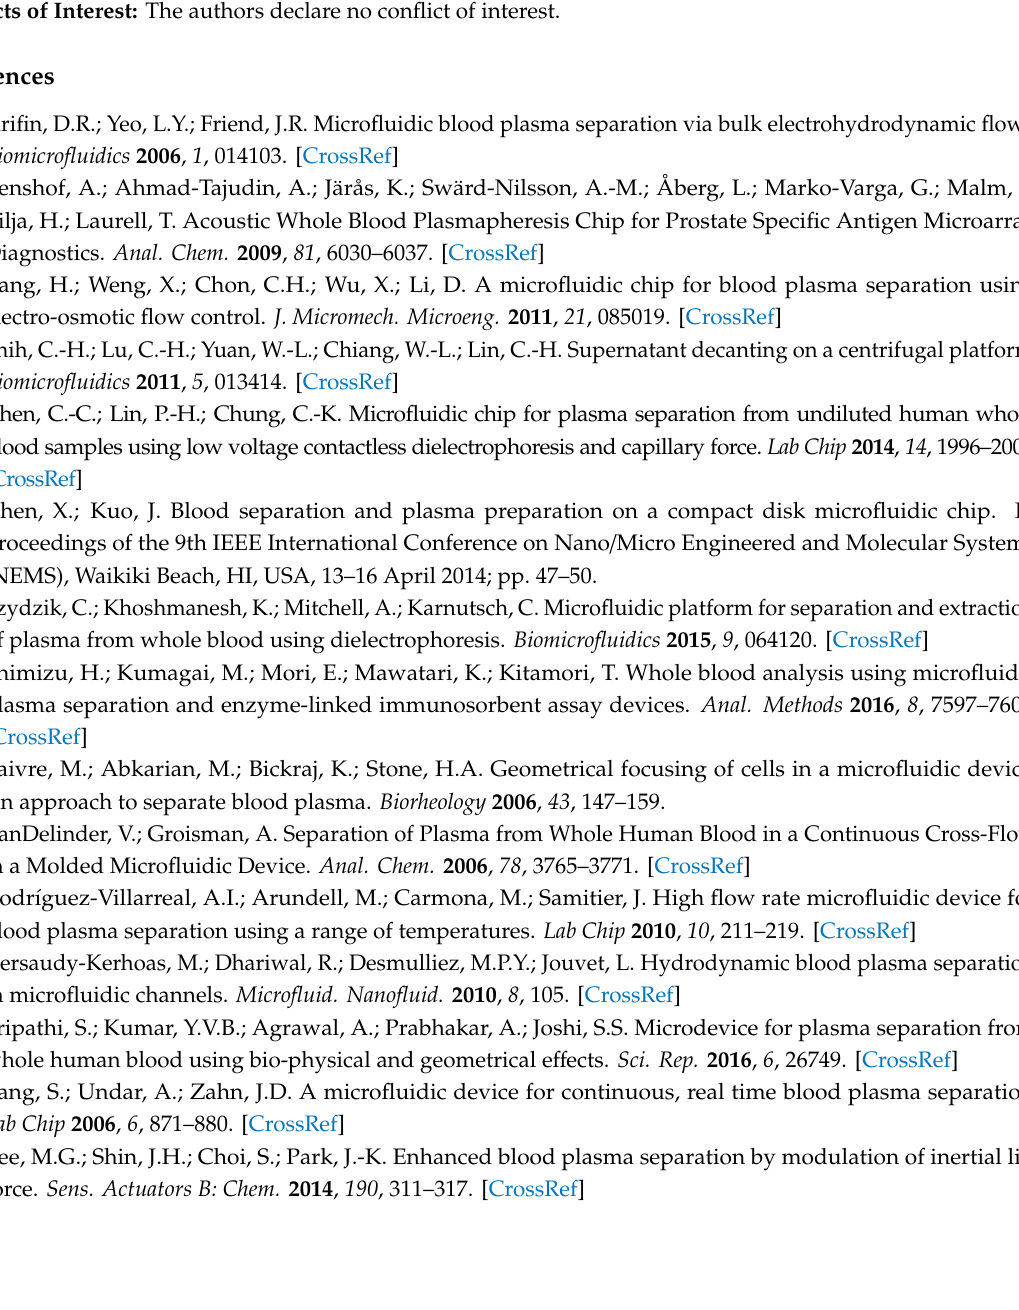
Figure S1: Mask design for layer-1 that was used to fabricate the Master. Figure S2: Mask design for layer-2 that was used to fabricate the Master. Figure S3: Mask design for layer-3 that was used to fabricate the Master. Figure S4: Schematic of the device design that was used for performing